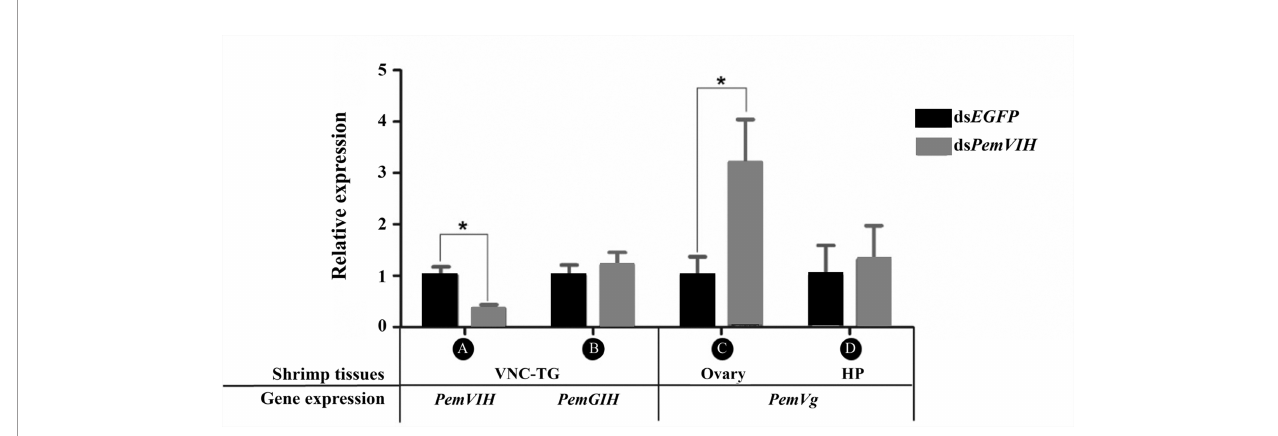
FIGURE 6 | Ef fi ciency of ds PemVIH on PemVIH suppression and its effect on vitellogenesis. The relative expression of (A) PemVIH and (B) PemGIH in ds PemVIH treated group compared with the ds EGFP treated group. PemVIH but not PemGIH , was signi fi cantly decreased. The relative expression level of PemVg in (C) ovary, but not (D) HP was signi fi cantly increased in ds PemVIH -injected group compared with the ds EGFP -injected group. Each bar = mean ± SEM (n = 10). Asterisks represented signi fi cant difference at *P ≤ 0.01 .